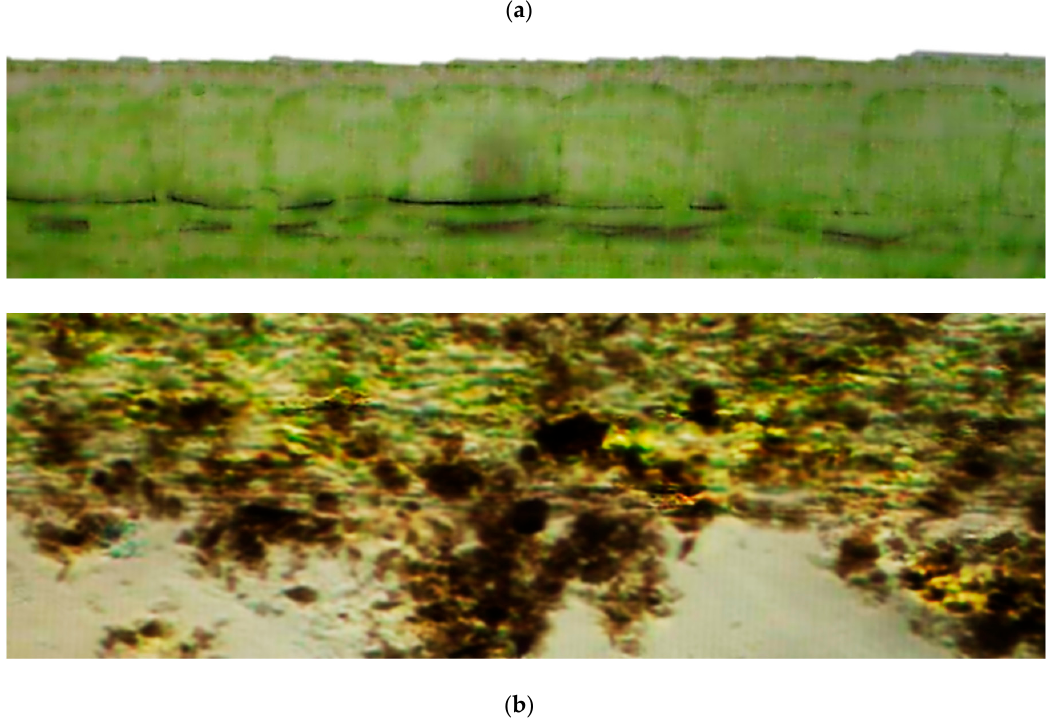
Figure 28. Roots of Lemna minor in ( a ) control and ( b ) treatment with 5 mg / L graphene oxide (GO). (Modified after [86] ).